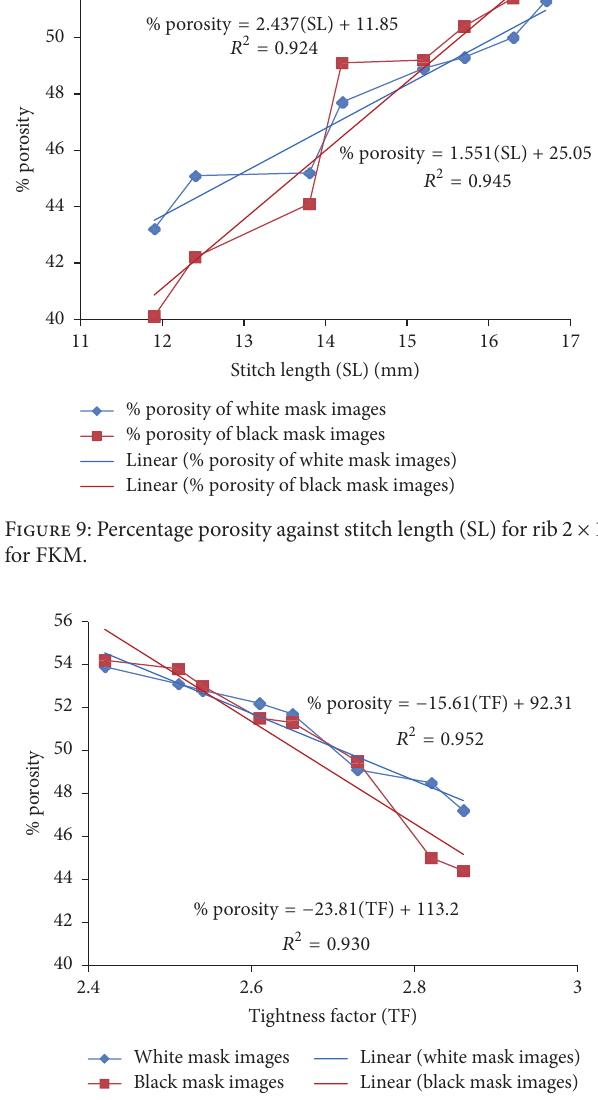
Figure 10: % porosity against TF for